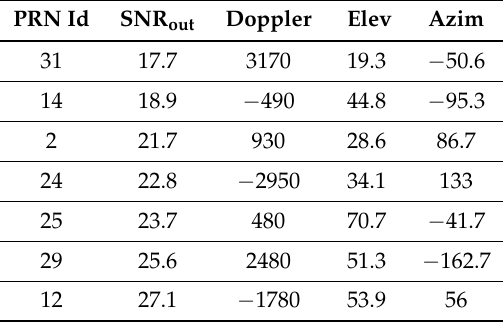
Table 1. Real-life GPS scenario: satellites in view (PRN Id), SNR out (dB), Doppler shift (Hz), elevation ( ◦ ) and azimuth ( ◦ ). Data were collected on 22 April 2015, GPS week number 1841, 16:07-16:10 (UTC). PRN